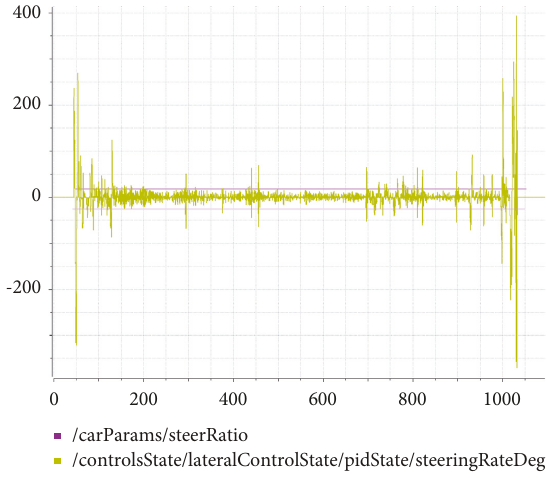
Figure 19: T1D4 steering